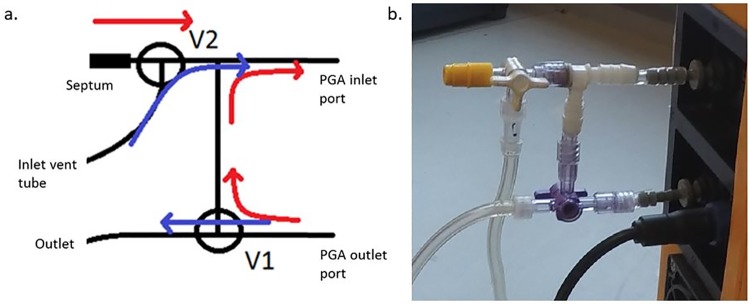
Schematic a. and image b. of the closed gas loop.The valves V1 and V2 are used for switching between venting, i.e., flushing the system with ambient air in (blue arrows) or closed-loop for sample testing (red arrows). The septum is used for sample injection using a syringe.